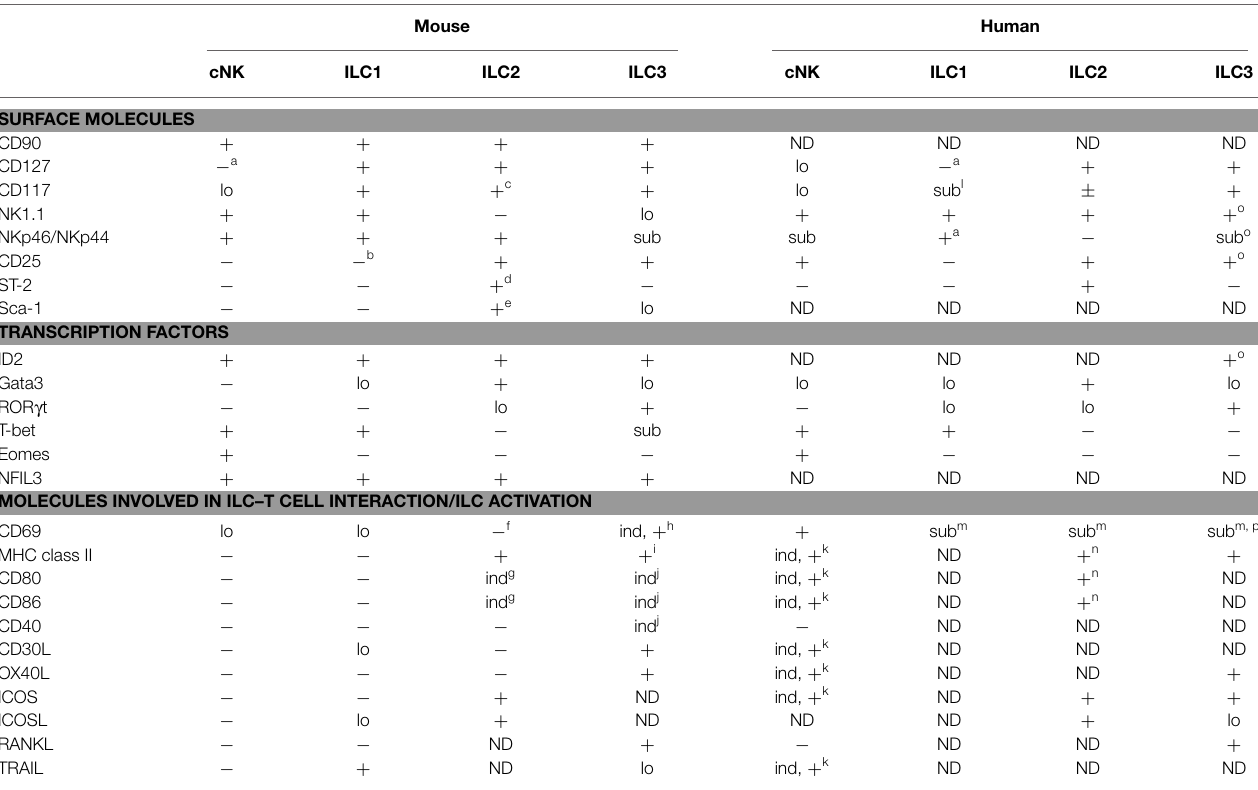
TABLE 1 | Phenotype of mouse and human ILCs